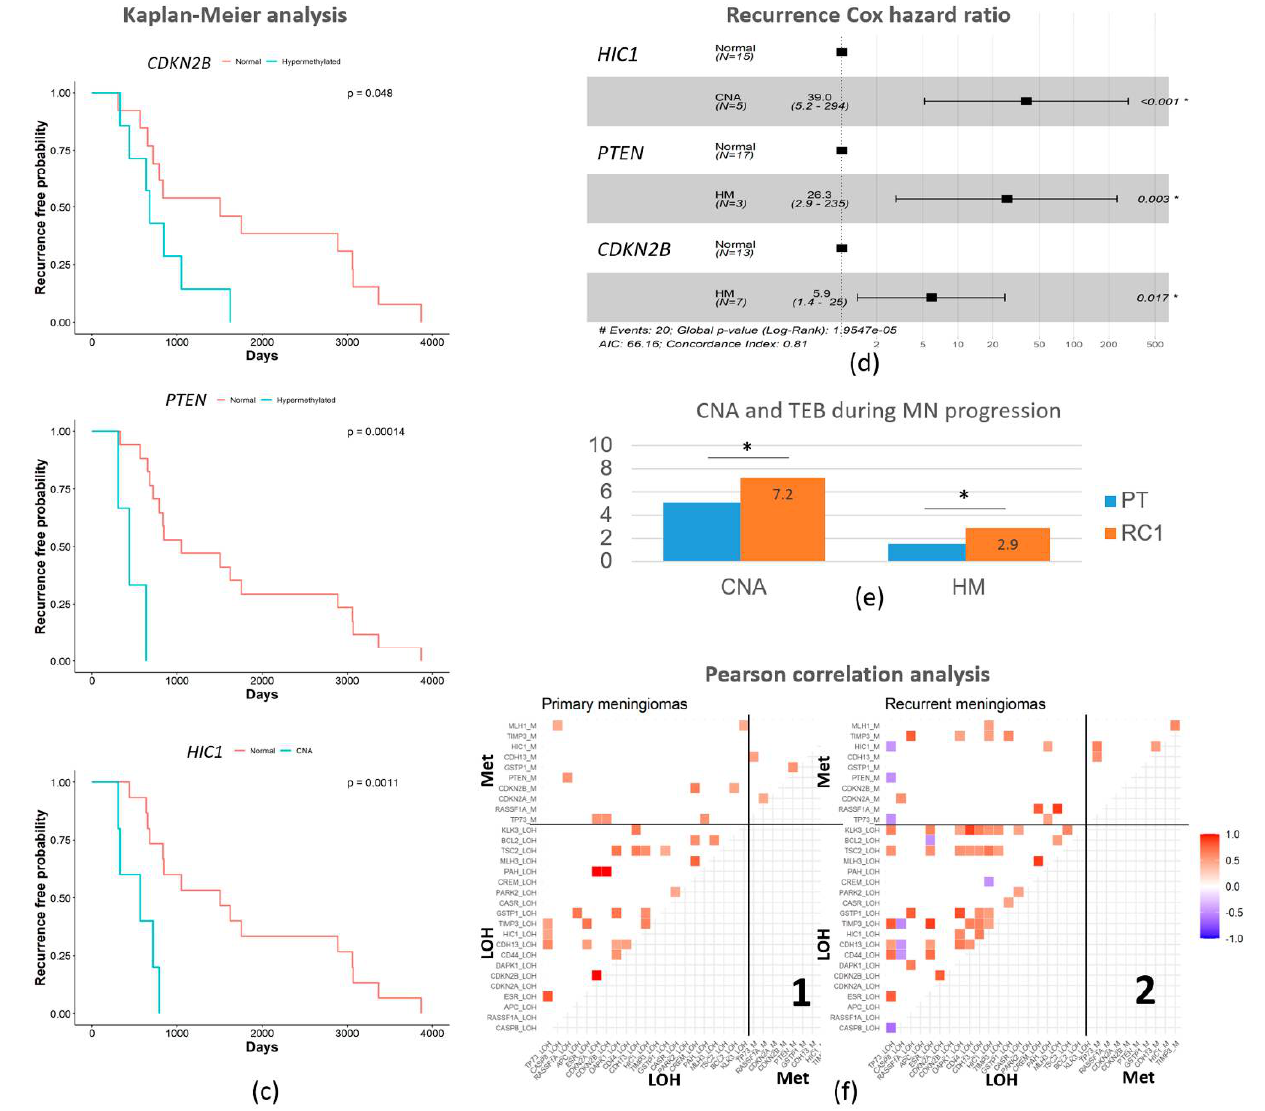
Figure 1. Genetic and epigenetic main characteristics. ( a ) Outstanding somatic copy number alterations on primary meningiomas depending on the tumor grade. ( b ) Copy number alterations and tumor epimutation burden (average number of epigenetic changes) according to recurrence-free survival period, divided into less than 1.5 years to the first recurrence or more than 1.5 years to the first recurrence. ( c ) Kaplan–Meier analysis of recurrence-free survival shows three independent prognostic factors: CDKN2B and PTEN epigenetic alterations (HM), and HIC1 copy number alteration (CNA). In each graph, the wild-type situation is in red and HM or CNA is in blue. ( d ) Cox Hazard ratio data to corroborate the strength of Kaplan–Meier analysis. ( e ) Evolution of the genetic and epigenetic burden from primary meningiomas to the first recurrence. ( f ) Pearson’s correlation analysis on primary meningiomas (PT) −1, and their first recurrences (RC1) −2. Positive correlations are in red meaning statistical co-alteration of a pair of genes, both in 1 and in 2. Negative correlations are in blue, meaning statistical alternations in the alteration of a pair of genes (a change detected in 1 is wild-type in 2 and vice-versa). The lower-left quadrant correlates the different CNAs among themselves on PT (1) and RC1 (2). The upper-left quadrant correlates the different CNA versus the different hypermethylation on PT (1) and RC1 (2). The upper right quadrant correlates the different hypermethylation among themselves on PT (1) and RC1 (2). The lower-right quadrant is empty. Abbreviations: GI, grade 1; GII-III, grade 2–3; MN, meningioma; PT, primary tumor; RC, recurrence; CNA, copy number alterations; TEB, tumor epimutation burden. (*) indicates p <